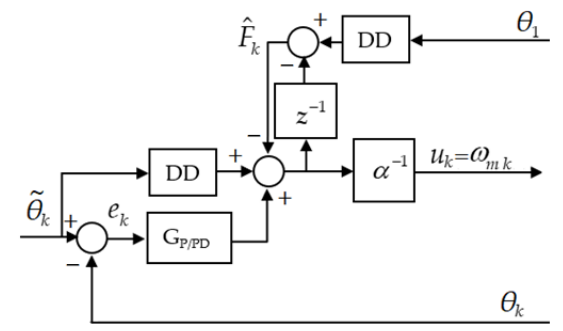
Figure 4. Model-free controller structure.